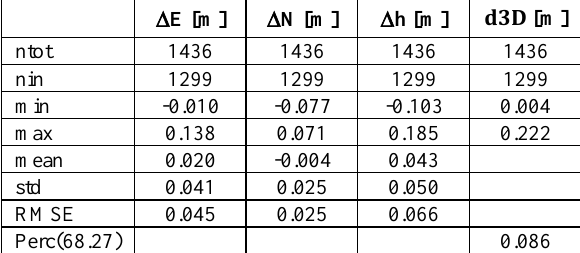
Table 3. Descriptive statistics for the whole dataset of the photogrammetric measurements.